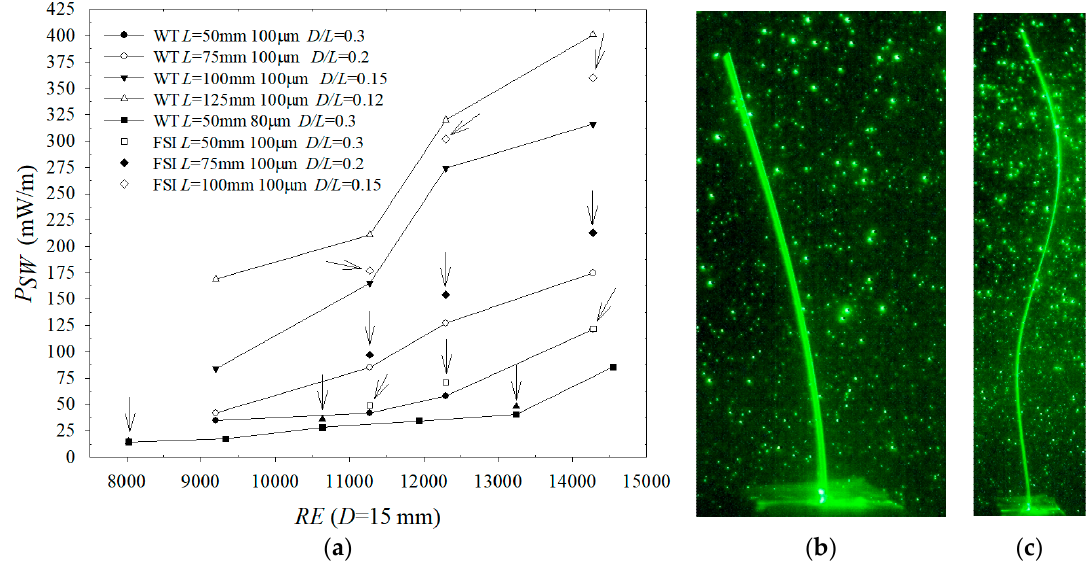
Figure 11. ( a ) Bending power evolution with the Reynolds number from water tunnel experiments, and FSI model results highlighted with the arrows; ( b ) high-strain-energy shape recorded at RE = 9202 L = 50 mm plate; ( c ) high-strain-energy shape recorded at RE = 9202 L = 125 mm plate.